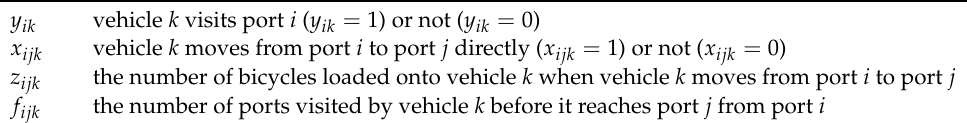
Table 2. The four decision variables used in the